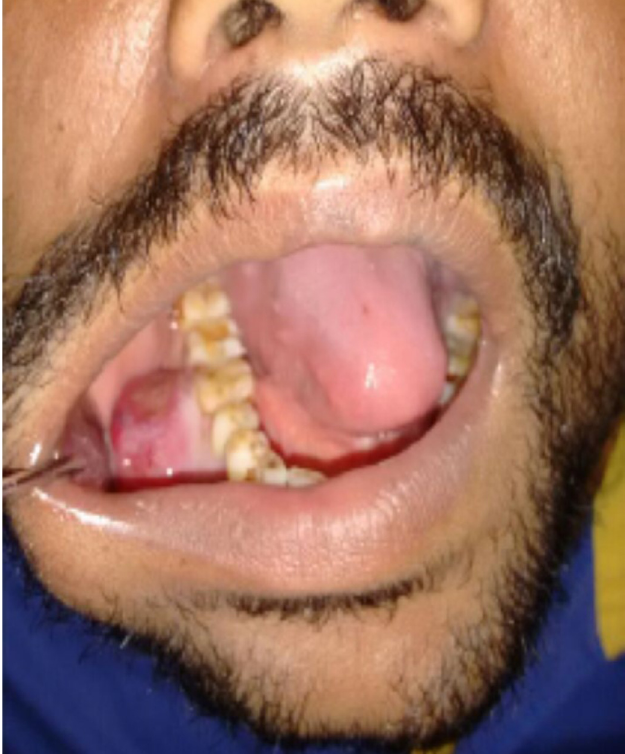
Fig. 1. A 3 (cid:1) 3cm nodular growth on the right mandibular alveolus.